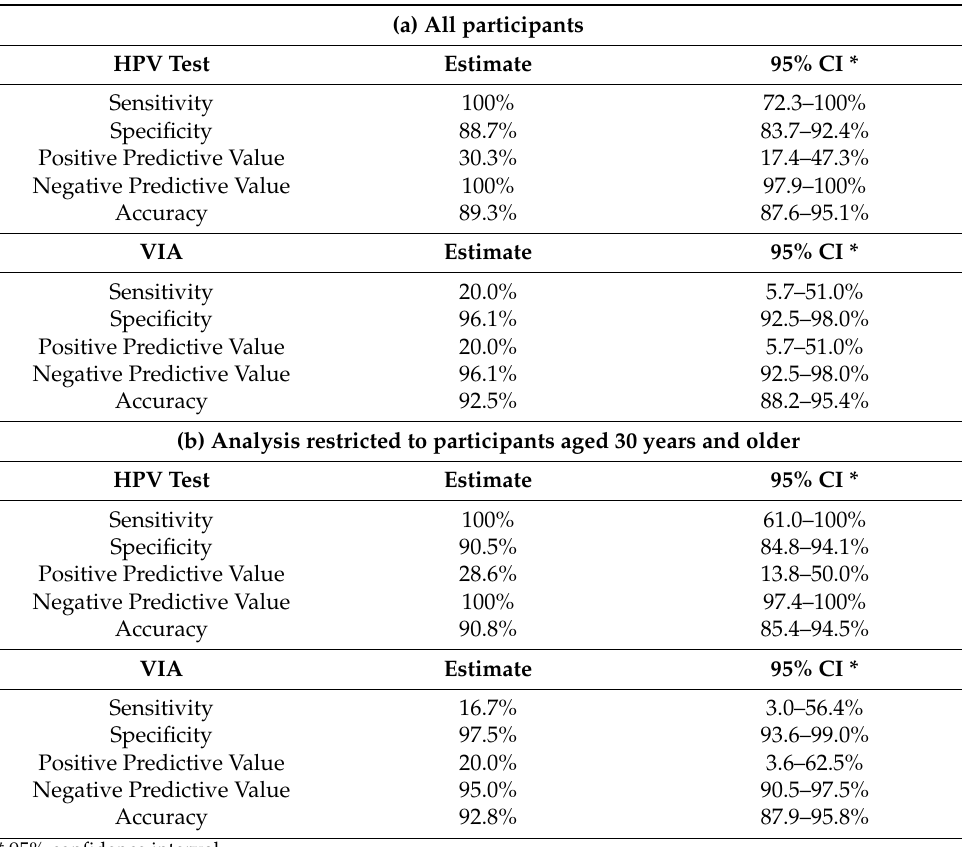
Table 2. Screening test (oncogenic human papillomavirus (HPV) testing and visual inspection with acetic acid (VIA)) performance relative to reference standard (cytological exam) in women participating in community-based cervical cancer screening, 2017, including: ( a ) all participants and ( b ) participants aged 30 years and